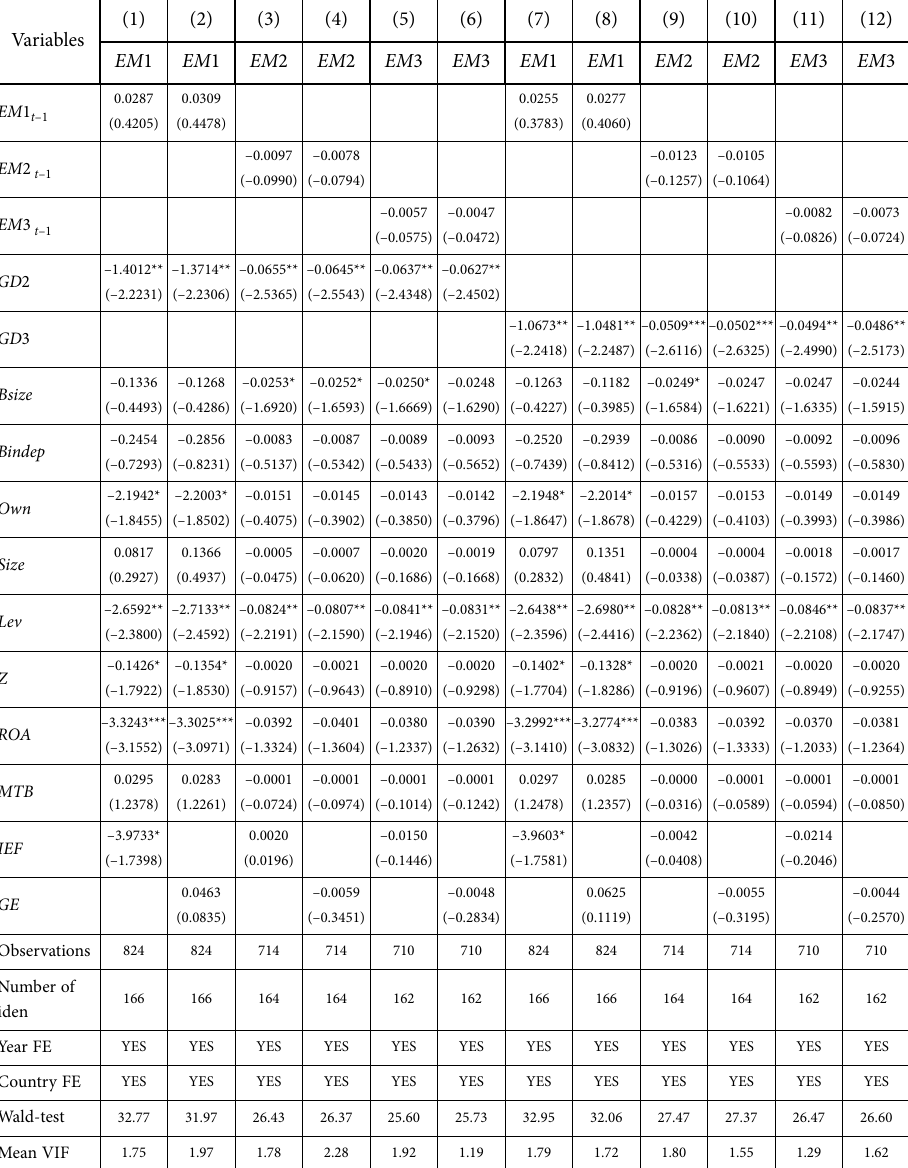
Table 7. Gender diversity and earnings management (GMM regressions)